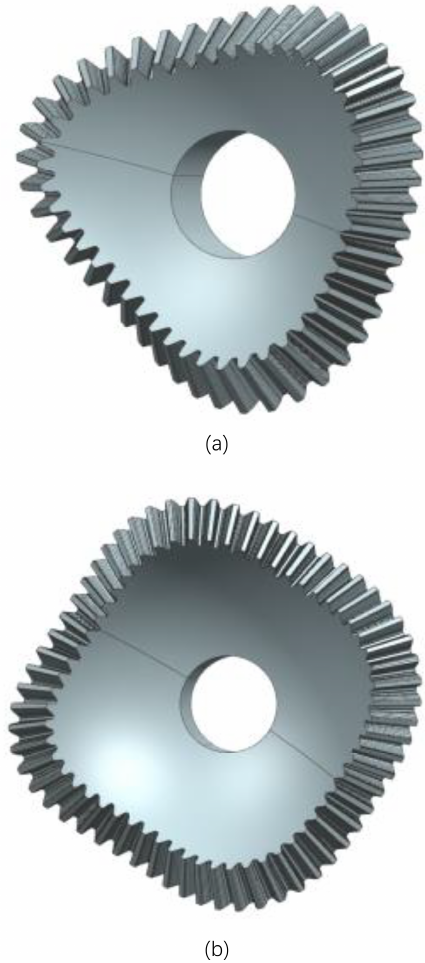
Figure 1. 3D modeling of noncircular bevel gears. (a) 3-lobed, (b) 4-lobed.